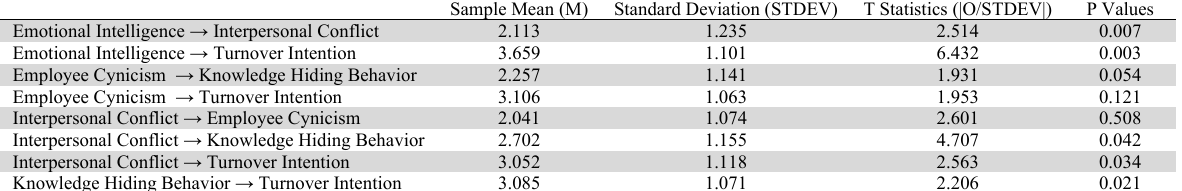
The Path Analysis (the result of direct and mediation effect)